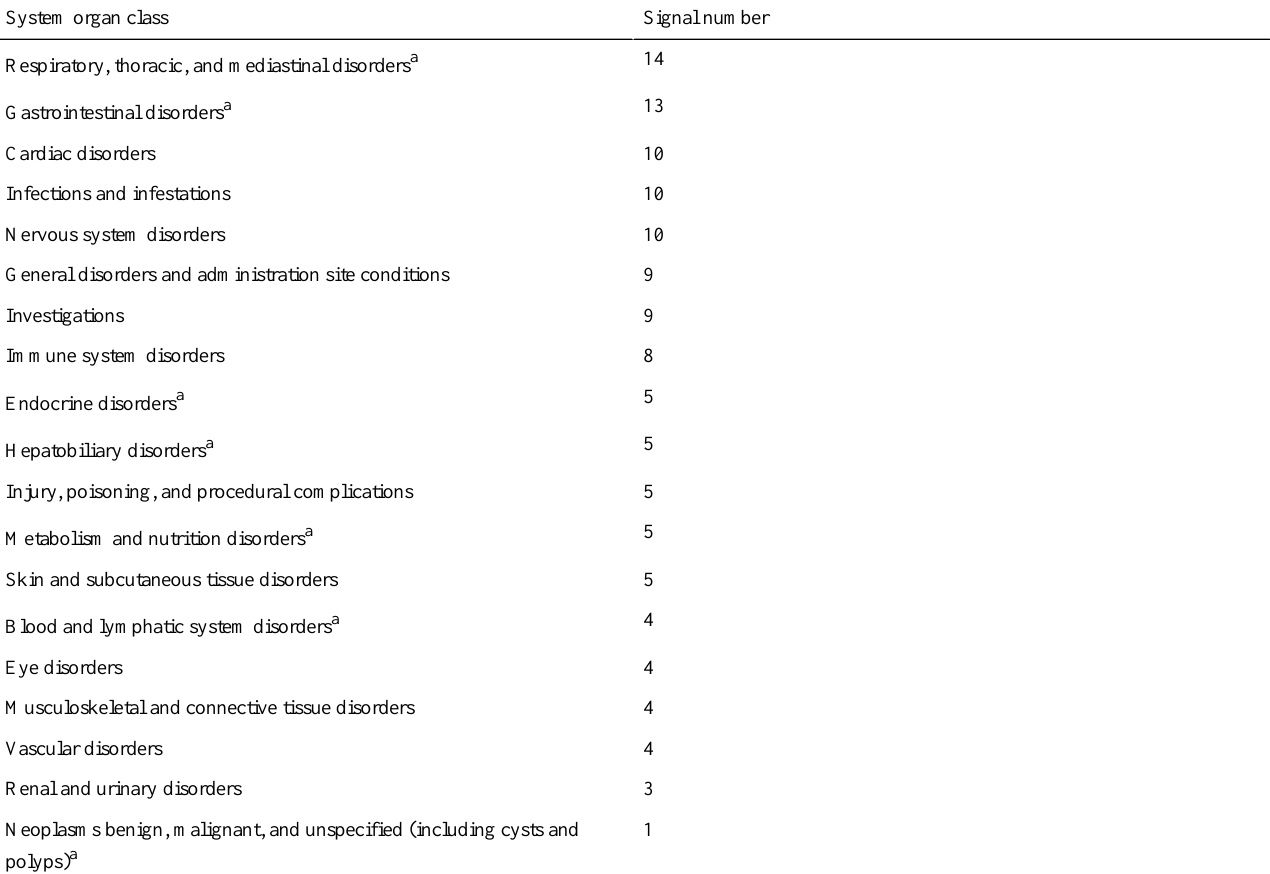
Table 5. System organ class distribution of preferred term–level